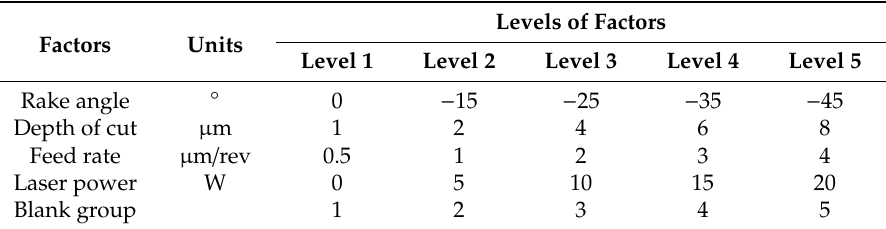
Table 2. Orthogonal parameters and corresponding